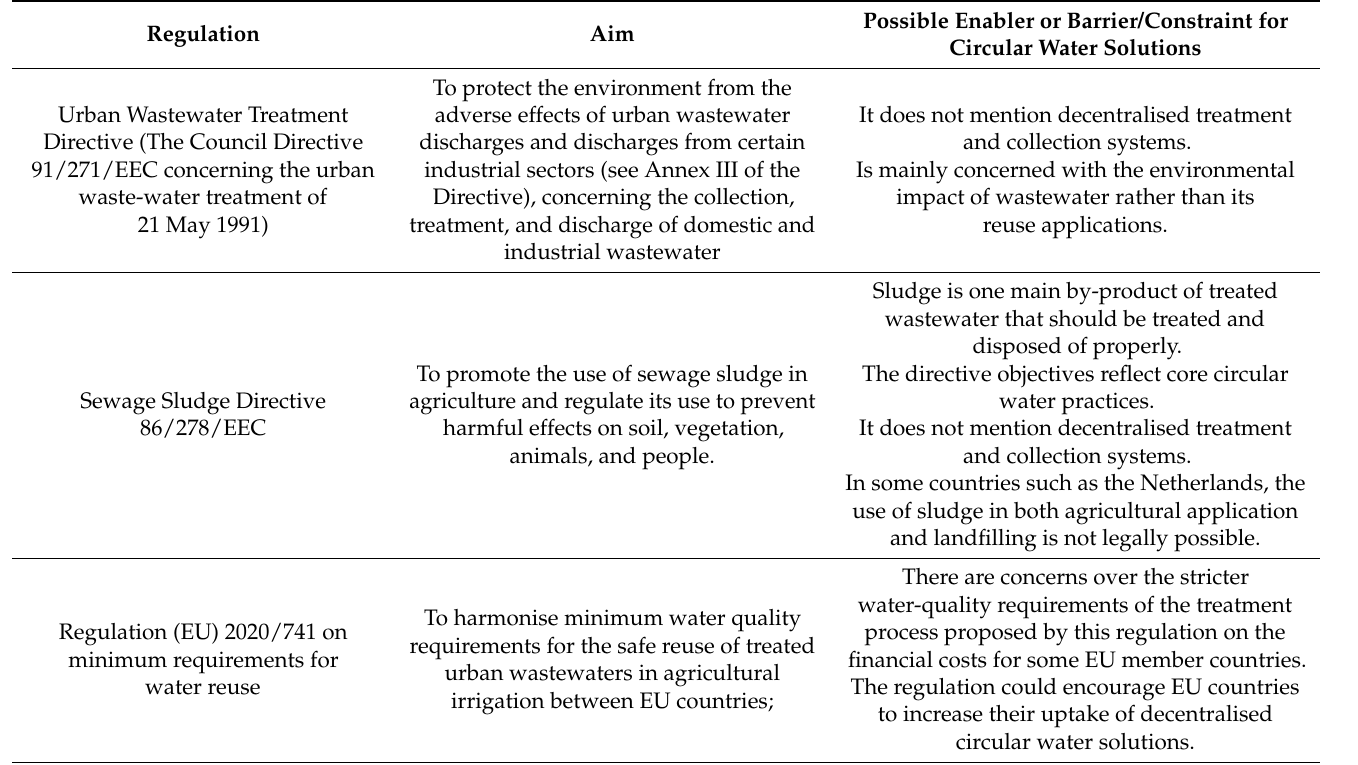
Table 1. Related European regulations for water in the